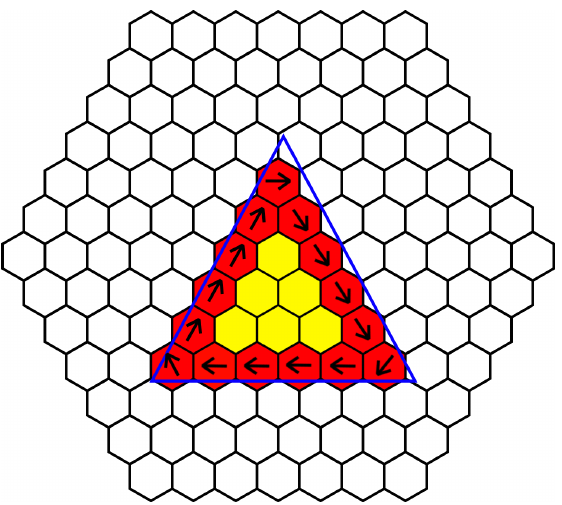
Figure 7. Rotation utilizing edge detection, where neighbors share information to detect the edge of an object and perform perpendicular beating to rotate an object. Red cells indicate edges, while yellow cells indicate an internal cell. Black arrows indicate the direction of ciliary beating and the blue triangle is where the object is placed, to illustrate placement of